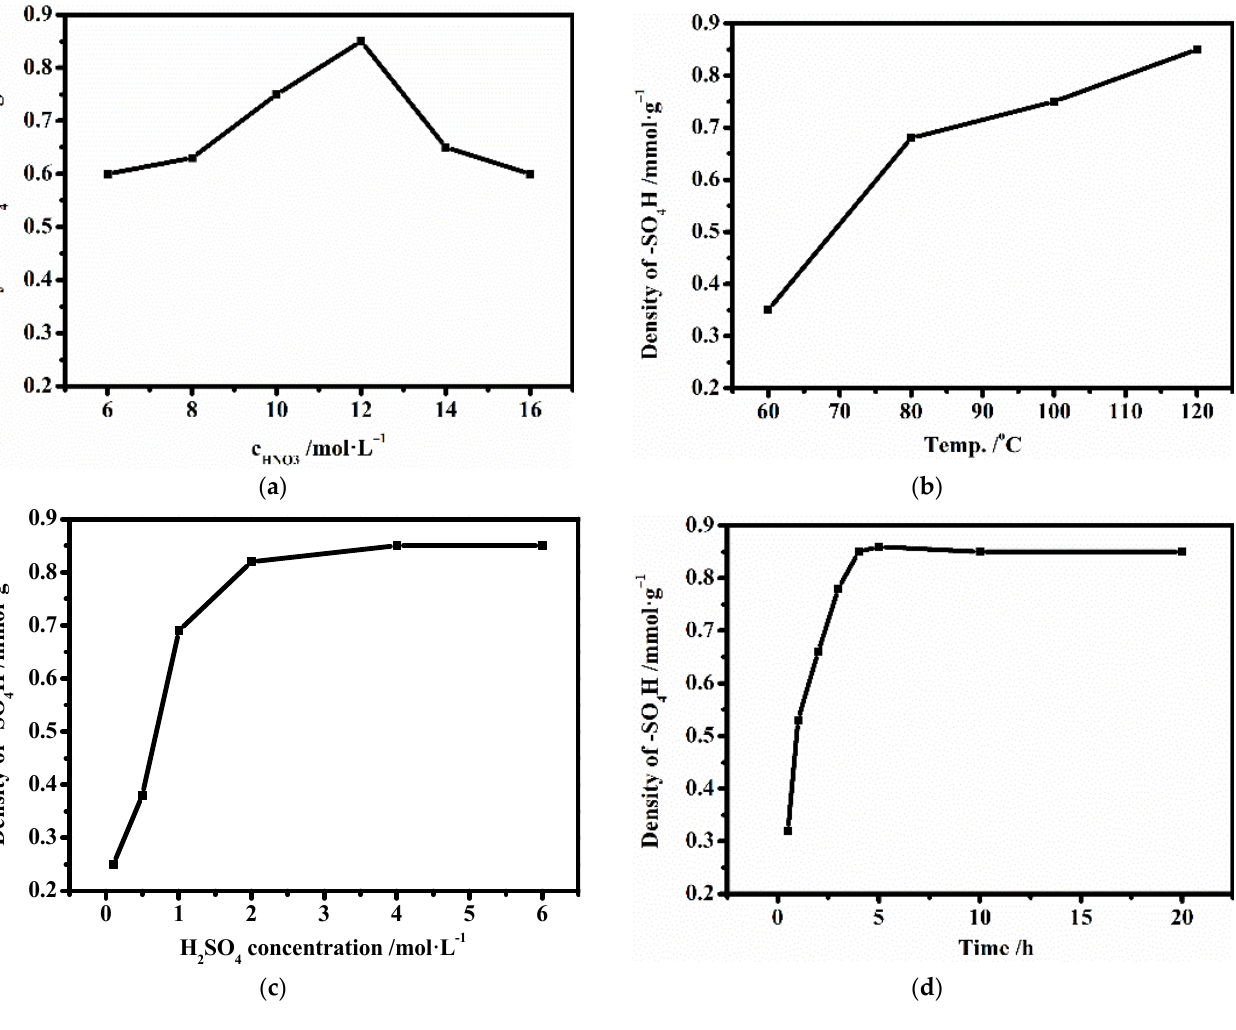
Figure 2. Effect of the preparation of AC-N-SO 4 H on the density of -SO 4 H. ( a ) HNO 3 concentration; ( b ) amination temperature; ( c ) H 2 SO 4 concentration; ( d ) impregnation time.